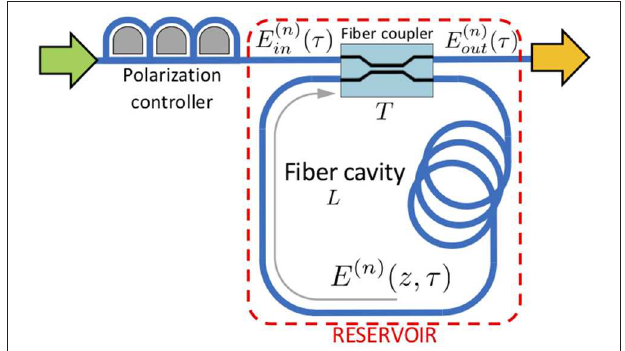
FIGURE 1 | Schematic of the fiber-ring cavity of length L used to implement an optical reservoir. The green (orange) arrow indicates a connection with an input (output) layer. A polarization controller maps the input polarization onto a polarization eigenmode of the cavity. A coupler with power transmission coefficient T couples the input field E ( n ) in ( τ ) to the cavity field E ( n ) ( z , τ ) and couples to the output field E ( n ) out ( τ ), where n is the roundtrip index, τ is time (with 0 < τ < t R ) and z is the longitudinal position in the ring cavity.